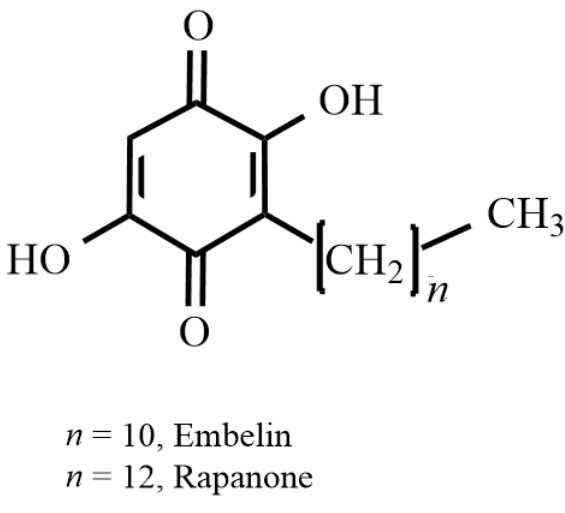
Figure 1. Structure of rapanone and embelin.